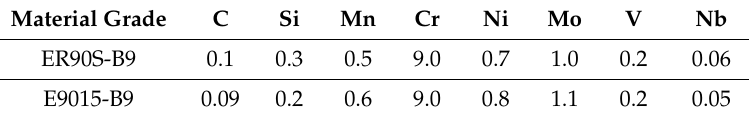
Table 2. Chemical composition of the weld metal (wt.